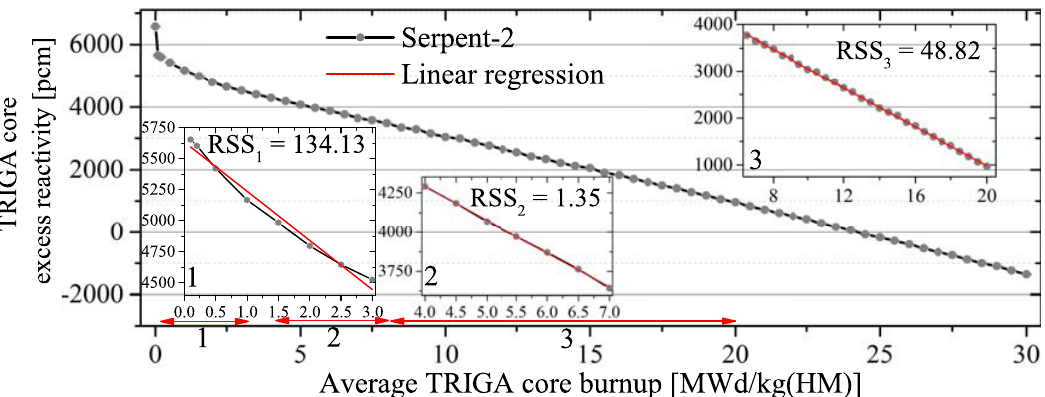
Figure 2: Linear assumption analysis of excess reactivity change in a TRIGA research reactor. For each linear fit Residual Sum of Squares ( RSS =